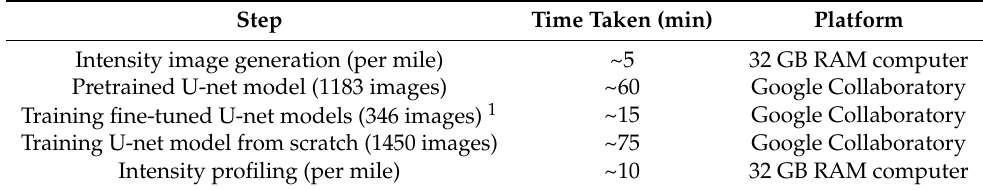
Table 2. Time taken by various steps in the proposed strategy for intensity image generation, U-net training, and intensity profile generation.